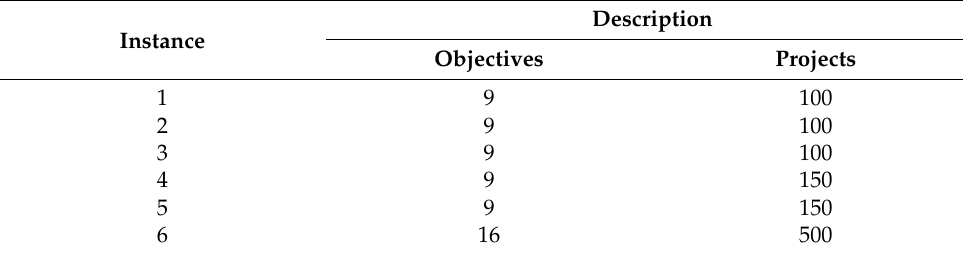
Table 2. Description of the instances used in the